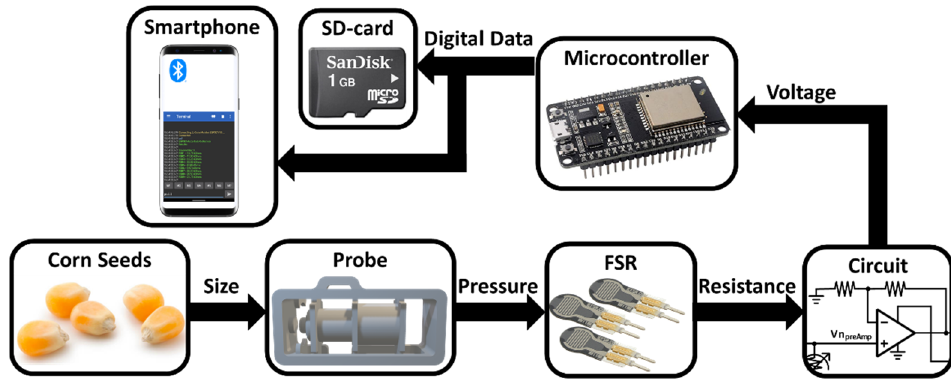
Figure 1. Proposed system diagram with its main components.